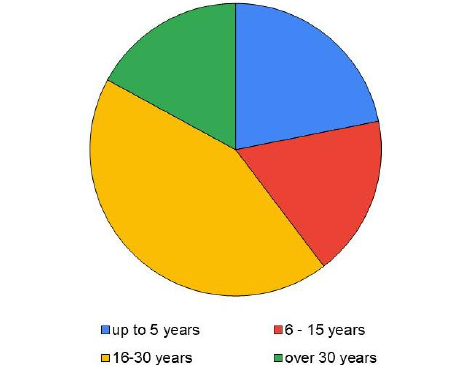
Fig. 1. Years of time employed as a geography